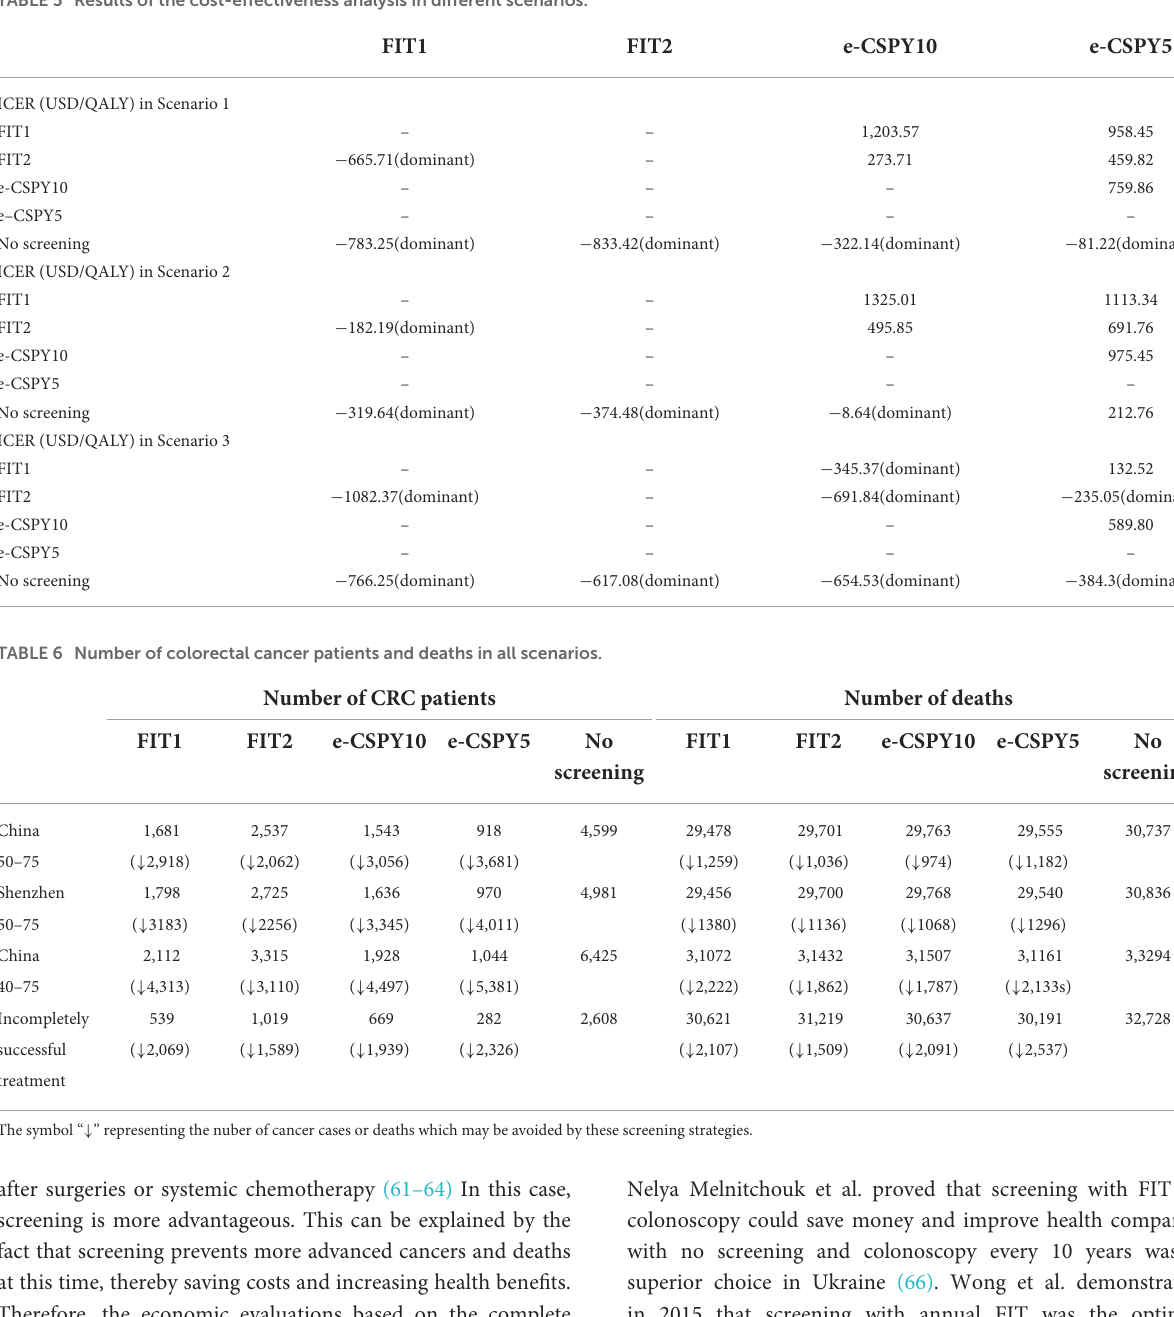
TABLE 5 Results of the cost-effectiveness analysis in different scenarios.